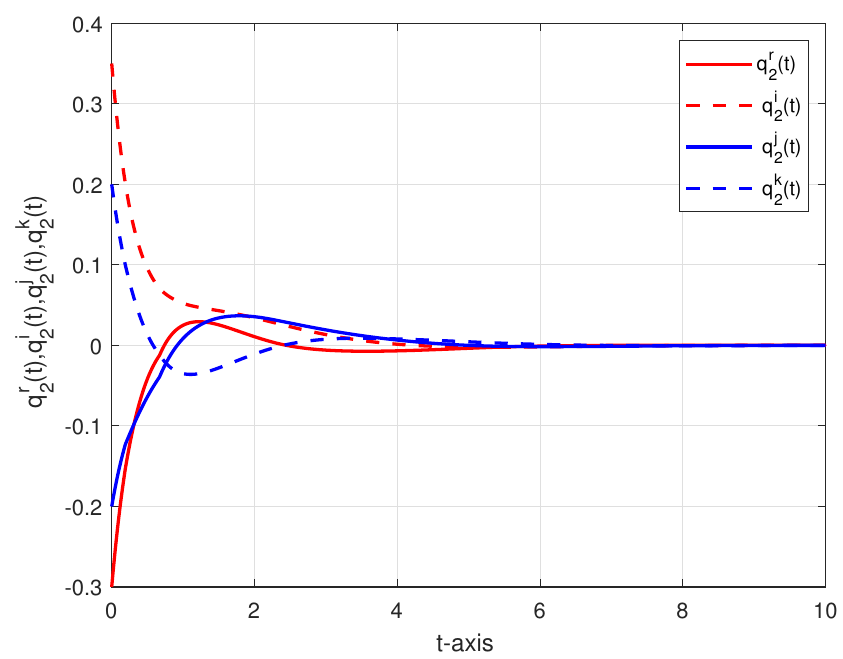
Figure 2. State trajectory of four parts of q 2 ( t ) for system